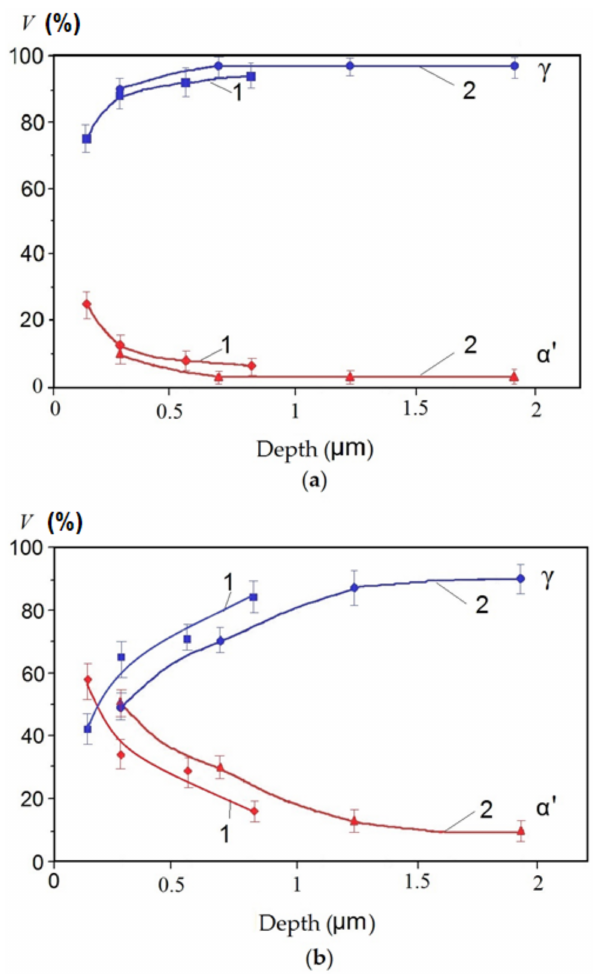
Figure 8. Depth dependences of phase composition for as-received ( a ) and Al-irradiated ( b ) steel, obtained from XRD data collected using CuK α (1) and CoK α (2) radiations. V is the phase volume fraction,